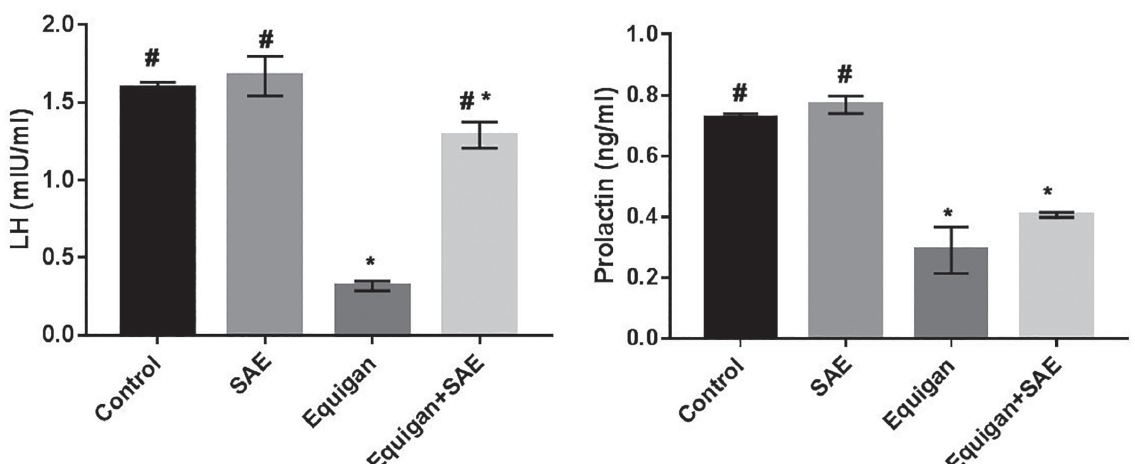
FIGURE 2 - Changes in the Luteinizing hormone (LH) and prolactin (PRL) hormone levels in the different groups. (Significant difference from the control group at * p < 0.05; Significant difference from Equigan group at # p < 0.05). TABLE III - Changes in the epididymal sperm count and vitality in the different groups under study Control SAE Equigan